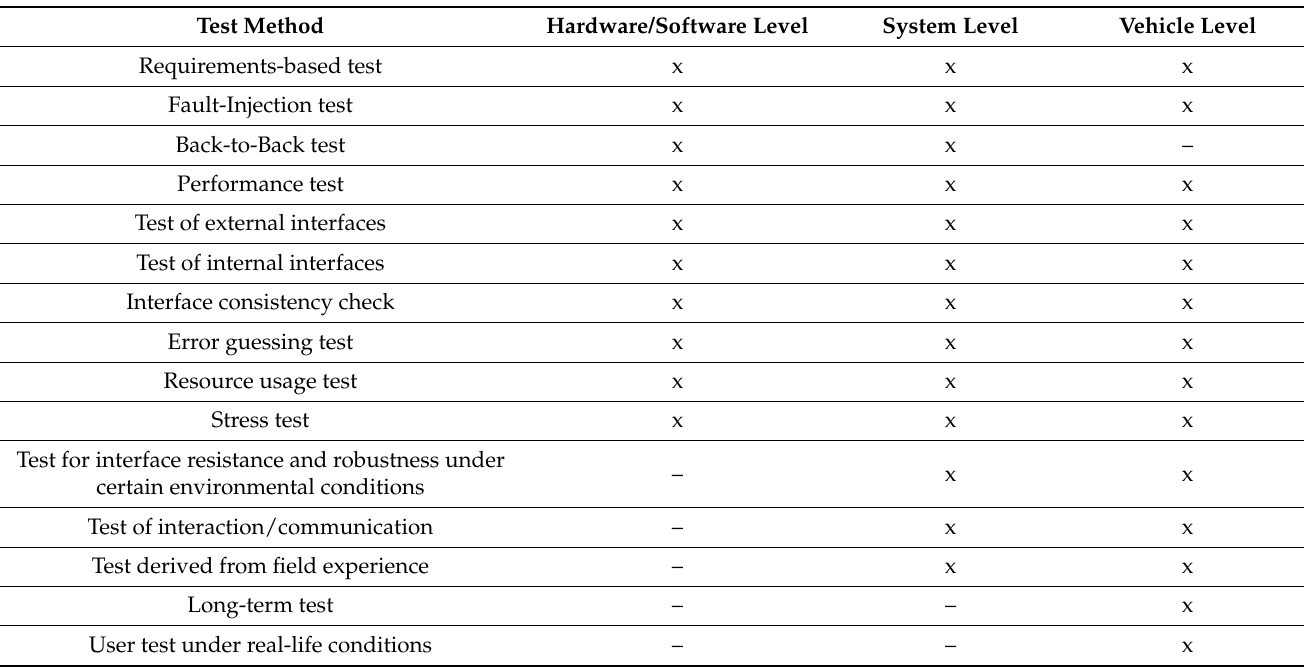
Table 1. Recommended test methods for different hierarchical levels according to ISO 26262. Crosses indicate recommenda- tion of the test method for the hierarchical